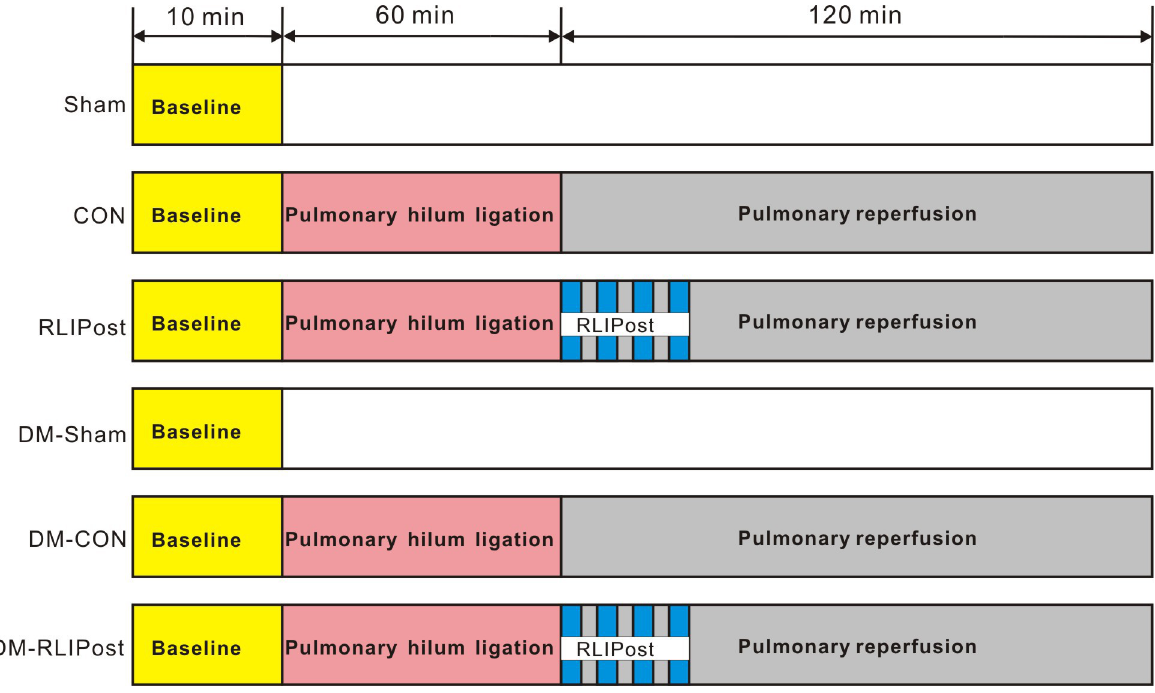
Fig 1. Experimental protocols. Lungs except for the sham-operated ones were subjected to pulmonary ischemia/reperfusion injury by ligation of the left pulmonary hilus for 60 min, followed by 120 minutes of reperfusion. Remote liver ischemic postconditioning (RLIPost) was conducted at the onset of pulmonary reperfusion by four cycles of 5 min of liver ischemia with 5 min intermittent reperfusions. Sham: sham-operated, CON: control, RLIPost: remote liver ischemia postconditioning, DM: STZ-induced